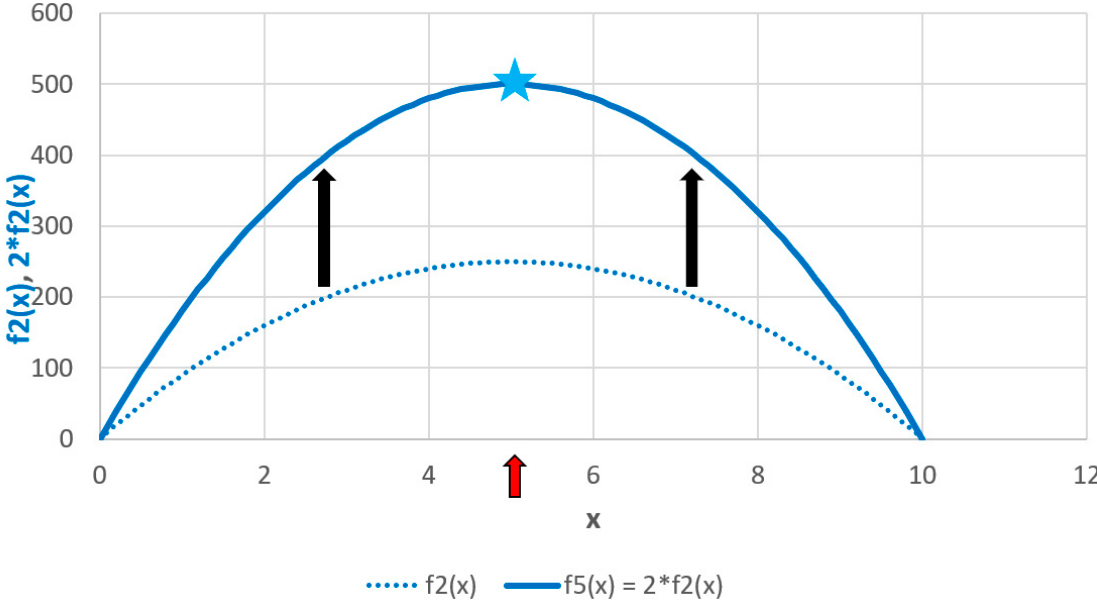
Figure 8. The net profit of BLUE, caused by expected net losses of RED, increases by 100%, for every possible level of x.